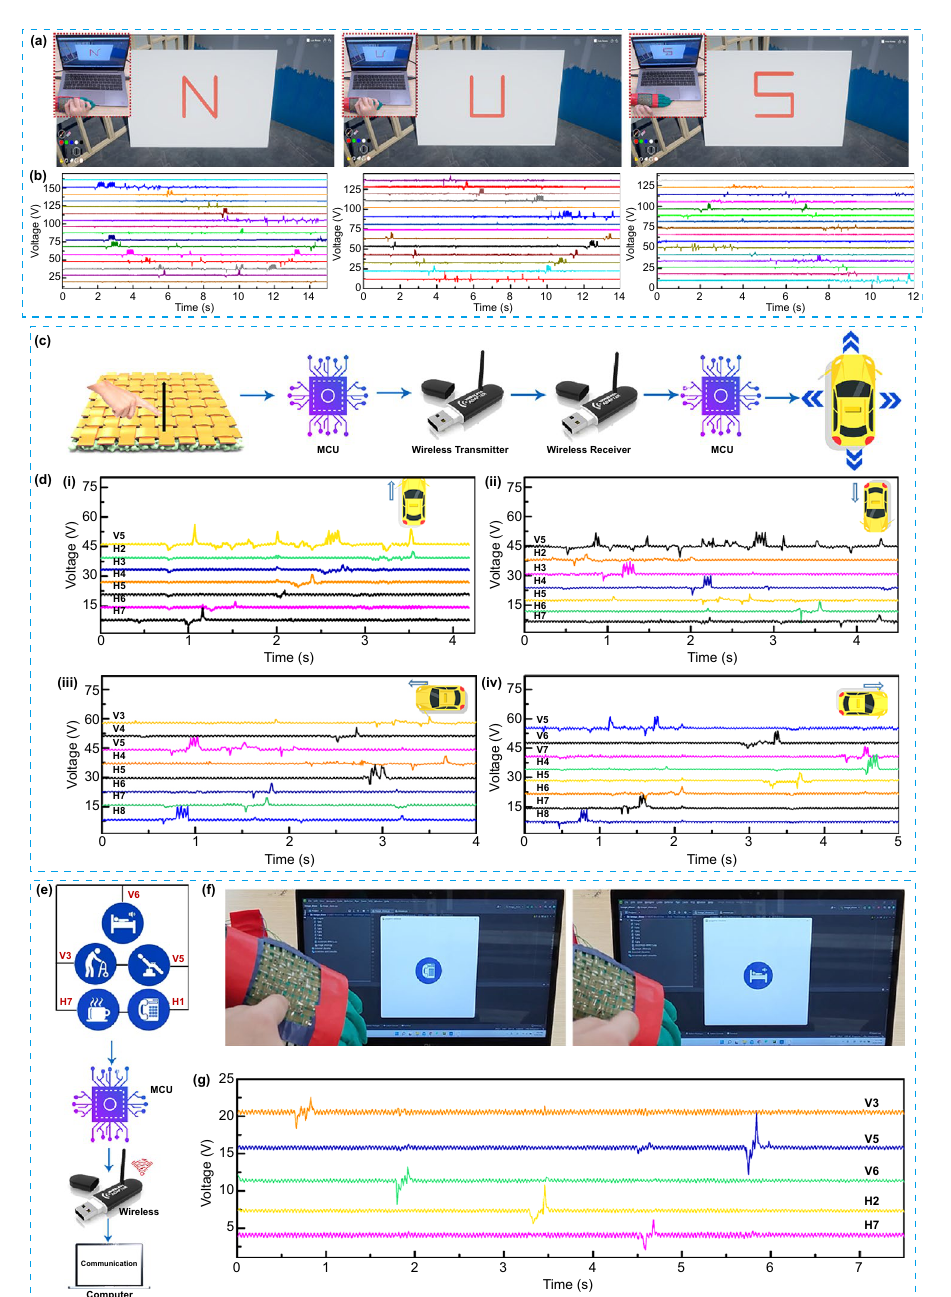
Fig. 5 Different applications of CSF-TENG-based HMI. a The corresponding screenshot of using steps to achieve VR control in Unity 3D, and the photographs of writing steps of 3 letters (inset). b The signal patterns of CSF-TENG corresponding to the three letters. Schematic illustration and real-time signals to control the vehicle by CSF-TENG. c Schematic illustration of CSF-TENG-based HMI for vehicle control. d The signal patterns of CSF-TENG corresponding to the four directions ( i–iv ). The corresponding movements of vehicle including forward/backward con- trol, and leftward/rightward control (inset). Wearable wireless communication board. e Circuit connection of the wireless communication board system. f The corresponding icons displayed on the screen and g real-time signals when the icons were pressed. (V and H represent vertical and horizontal channel, for example, vertical channel 5 and horizontal channel 5 are abbreviated as V 5 and H 7,